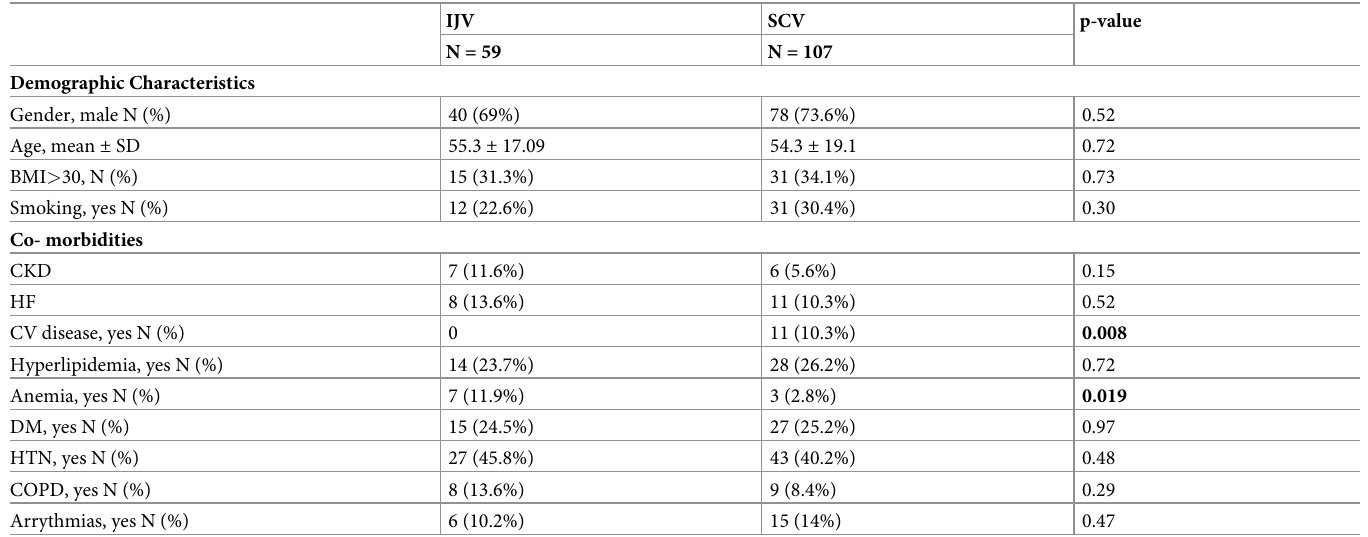
Table 1. Patients baseline characteristics.